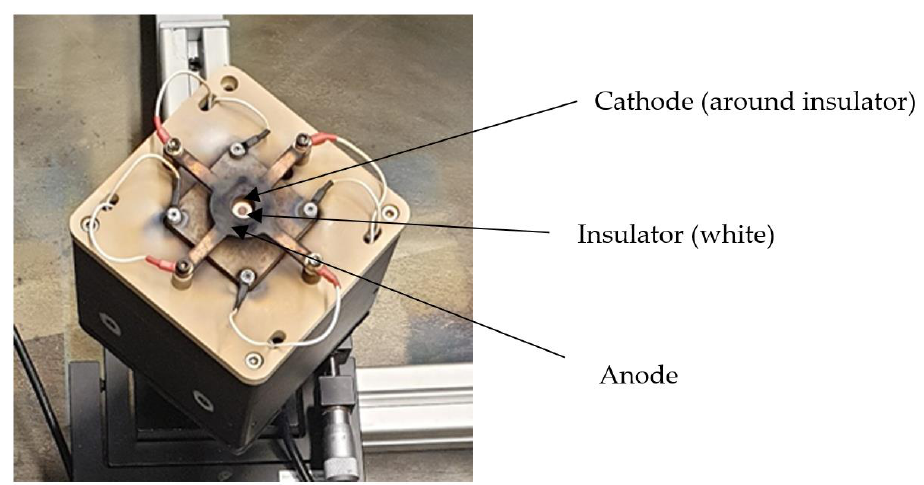
Figure 1. The used PJP model mounted centrally in the vacuum chamber.